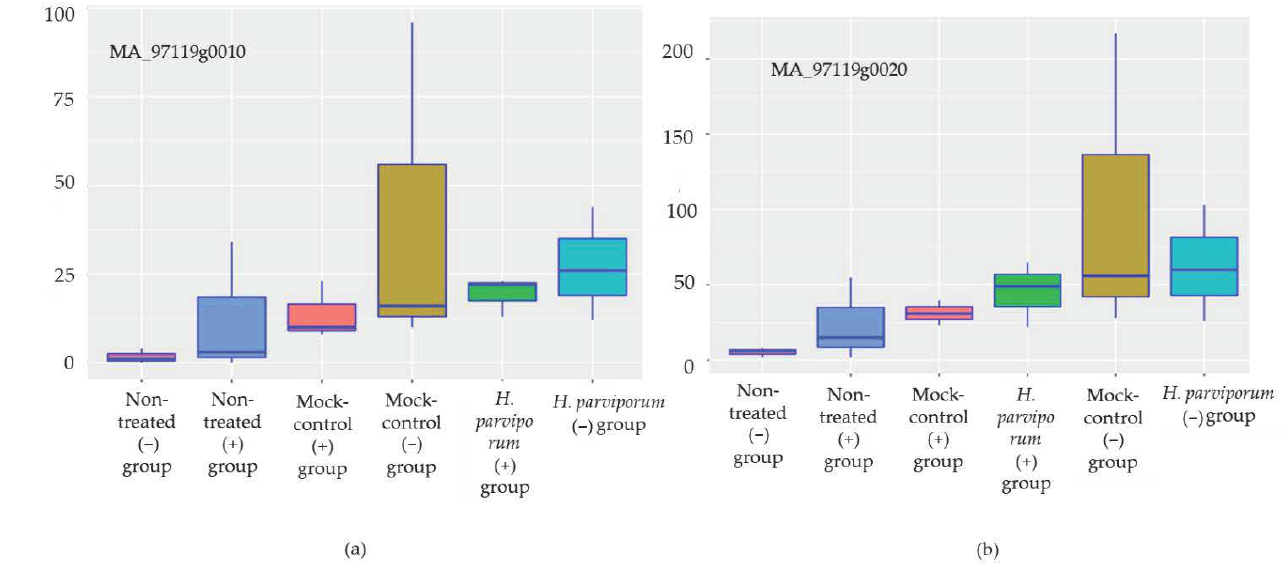
Figure 3. Palac5 ( a ) MA_97119g0010 and ( b ) MA_97119g0020 gene expression levels in each treatment. Table 3. Mean Fold Change of Each Candidate Gene in qRT-PCR for Each Treatment Scheme.